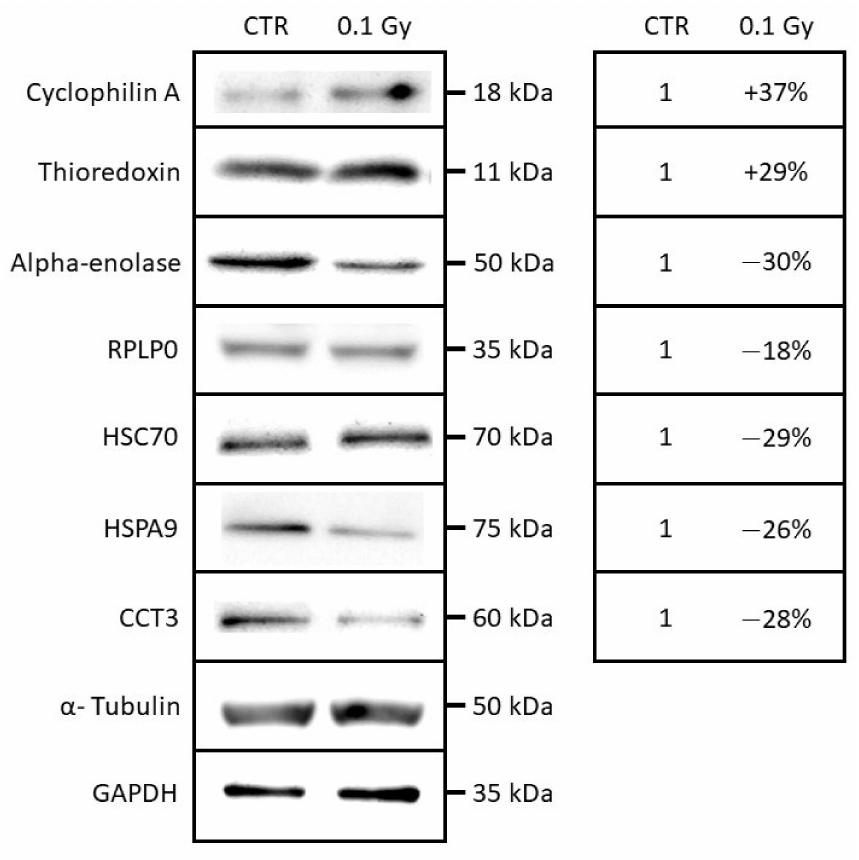
Figure 5. Western blotting analysis of cyclophilin A, thioredoxin, alpha-enolase, RPLP0, HSC70, HSPA9, and CCT3 in a whole-cell extracts from T/C-28A2 bystander cells receiving the conditioned medium of low-dose irradiated chondrosarcoma cells (0.1 Gy) or non-irradiated chondrosarcoma cells